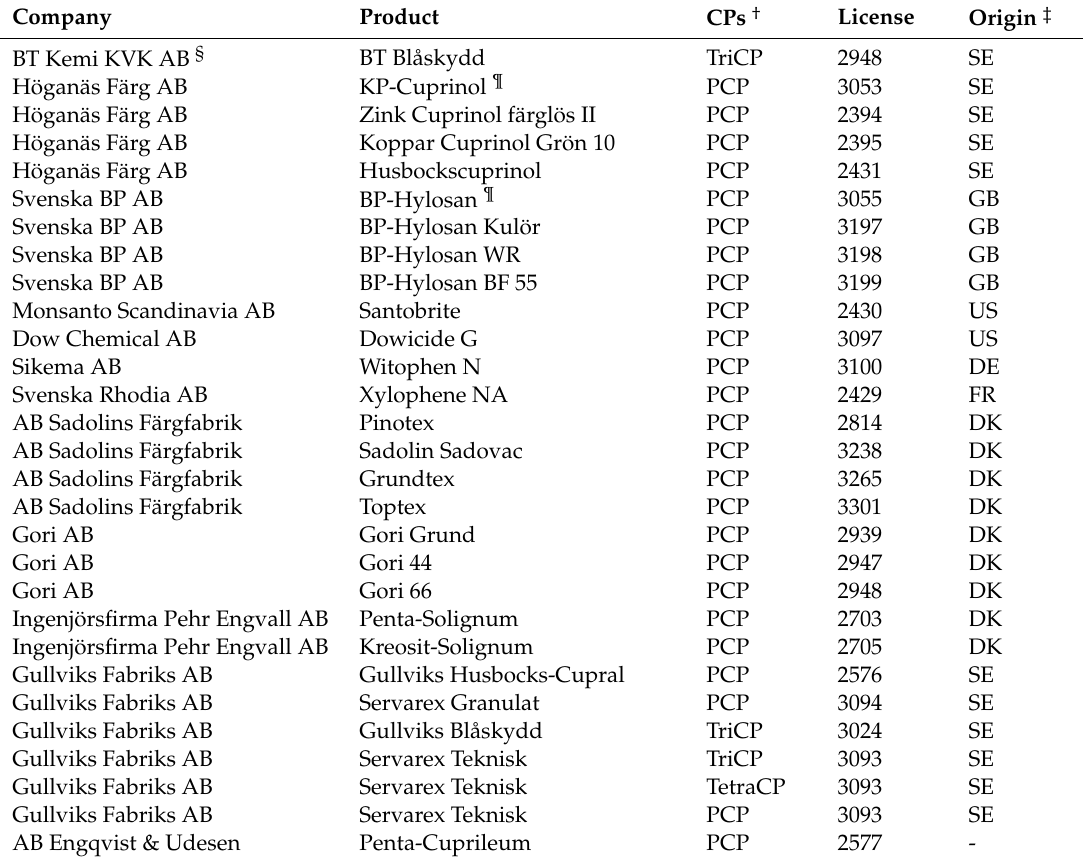
Table A2. Products that had their licenses withdrawn by Produktkontrollnämnden in 1977. The products contained chlorophenols (CPs) and were intended for fabrics, paints, wood preservation and